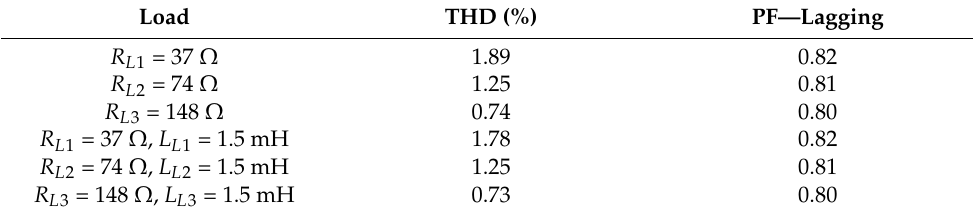
Table 10. ATU total harmonic distortion and power factor.